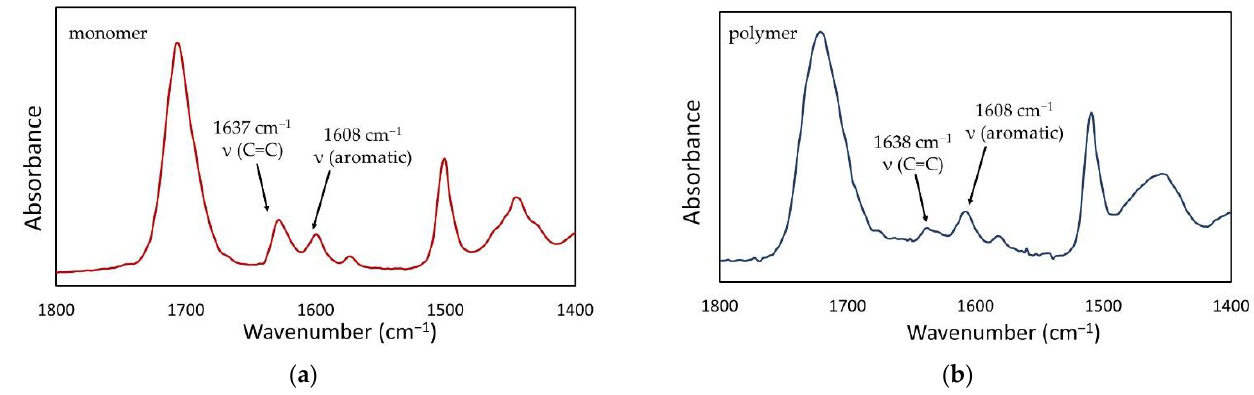
Figure 7. The representative FTIR spectra of the Bis-GMA/TEGDMA composition containing 0.5 wt.% QA-PEI-NPs in its uncured ( a ) and cured ( b ) forms.